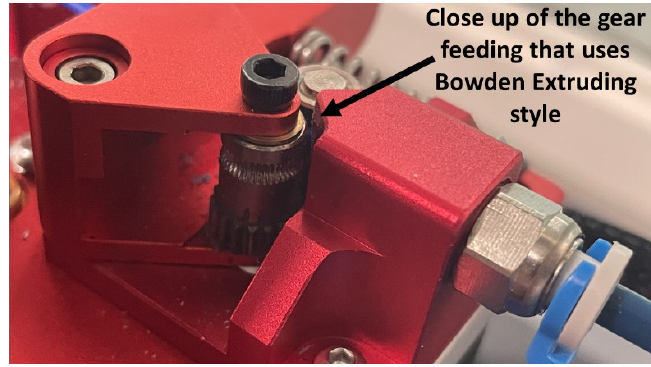
Figure 4. Close-up of the gear feeding that uses the Bowden extruding